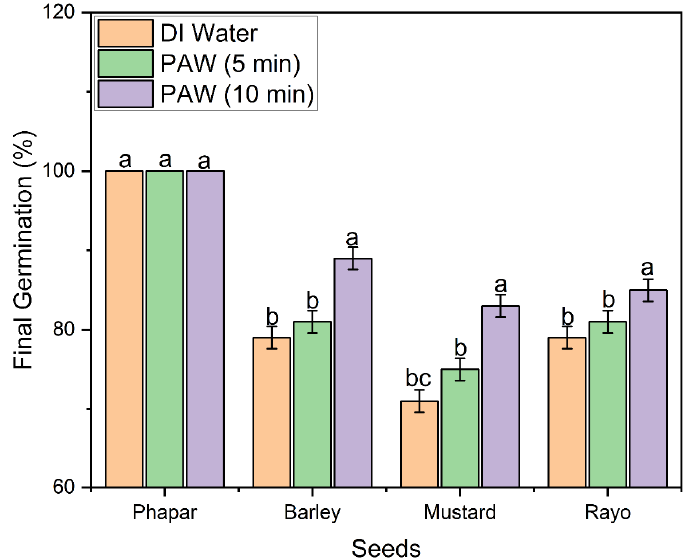
Figure 5. Effect of plasma-activated water on the germination of seeds. Different letters (a–c) indicate significant differences at p < 0.05 level among all treatments as determined by Tukey’s multiple comparison test.